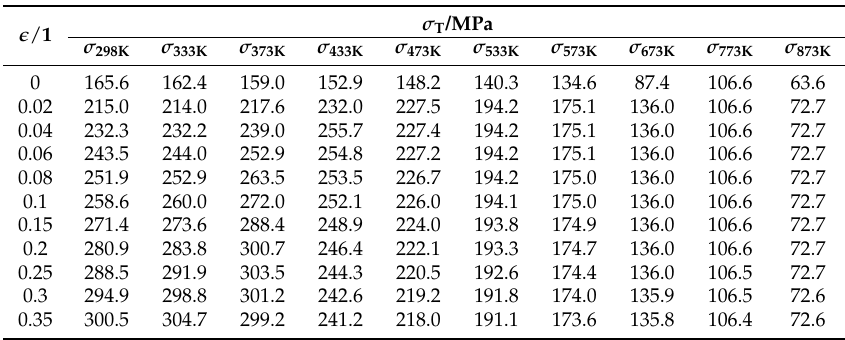
Table A4. Flow Stress of